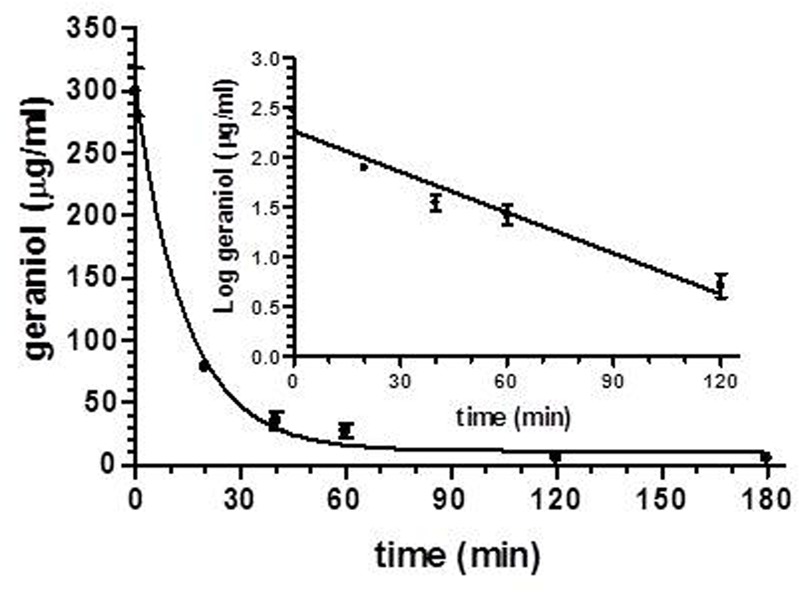
Elimination profile of geraniol after 12.5 mg intravenous infusion to rats. Data are expressed as the mean ± SE of four independent experiments. The elimination followed an apparent first order kinetics, confirmed by the semilogarithmic plot reported in the inset (n = 5, r = 0.963, P < 0.0001). The half-life of geraniol was calculated to be 12.5 ± 1.5 min.